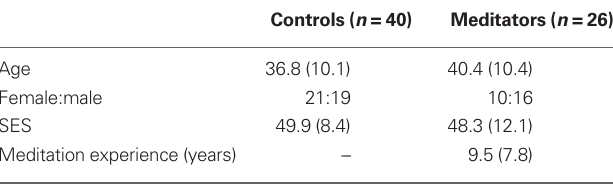
Table 5 | Demographic variables of controls and meditators.